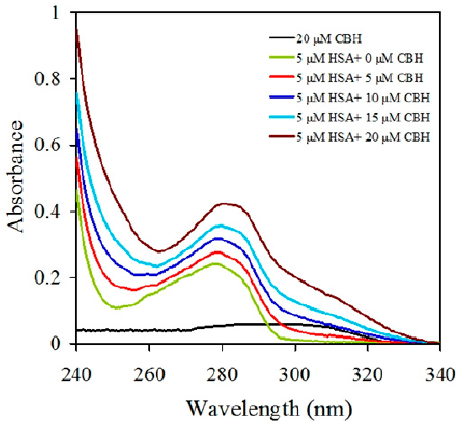
Figure 2. Changes in the UV–VIS absorption spectrum of human serum albumin (HSA) in the absence and presence of different concentrations of cyclobenzaprine hydrochloride (CBH) at pH 7.4 and temperature 25 °C. The black line shows the UV–VIS absorption spectrum of CBH only.